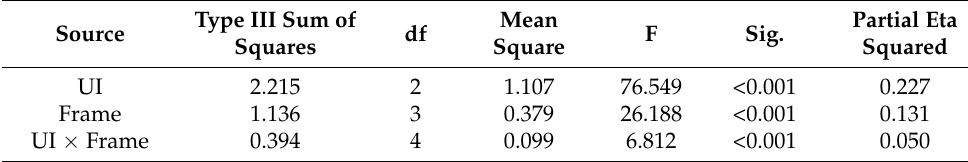
Table 8. Tests of between-subjects effects. Dependent Variable: